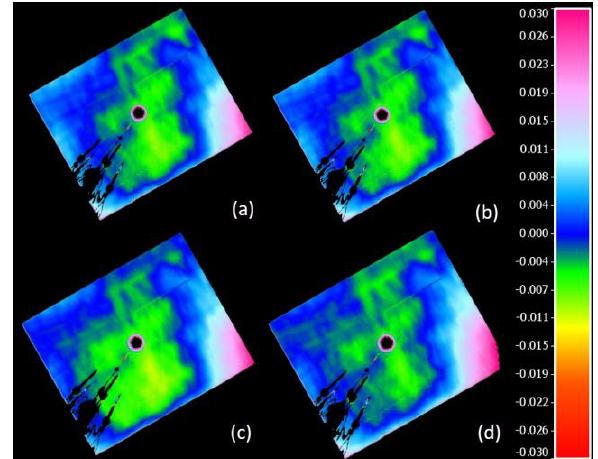
Figure 9. Distance of original points from a plane estimated at the 4 different resolution: (a) 2.5 mm; (b) 1 cm; (c) 5 cm; (d) 10 cm.